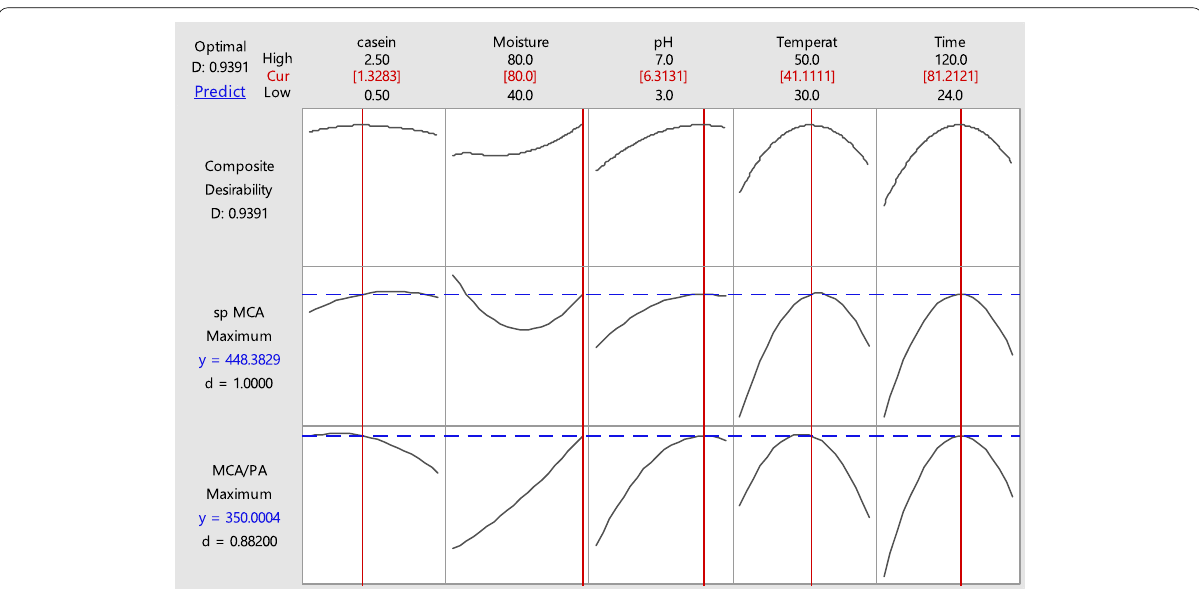
Fig. 1 Multiple response optimization of protease production. Columns represent the effect of each factor on the responses (rows). Vertical red lines represent the optimal values of the independent variables yielding the desired responses. Horizontal blue lines represent the predicted values of responses for the optimal set of independent variables. The numbers in the first row represent the range for each factor and its optimal value (shown in red). Optimal values of responses are shown in the first column (blue values). D is the composite desirability index, encompassing all responses; d is the individual desirability index. (0 di 1) higher index values reveal higher desirability, whereas 1 represents a completely ≤ ≤